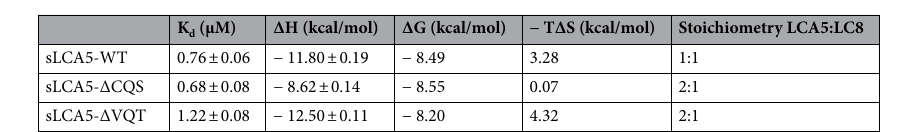
Table 1. Measured binding affinities, thermodynamic properties, and binding stoichiometries. Thermodynamic and kinetic parameters of interaction between LC8 and wild type and single mutant forms of sLCA5 and their corresponding